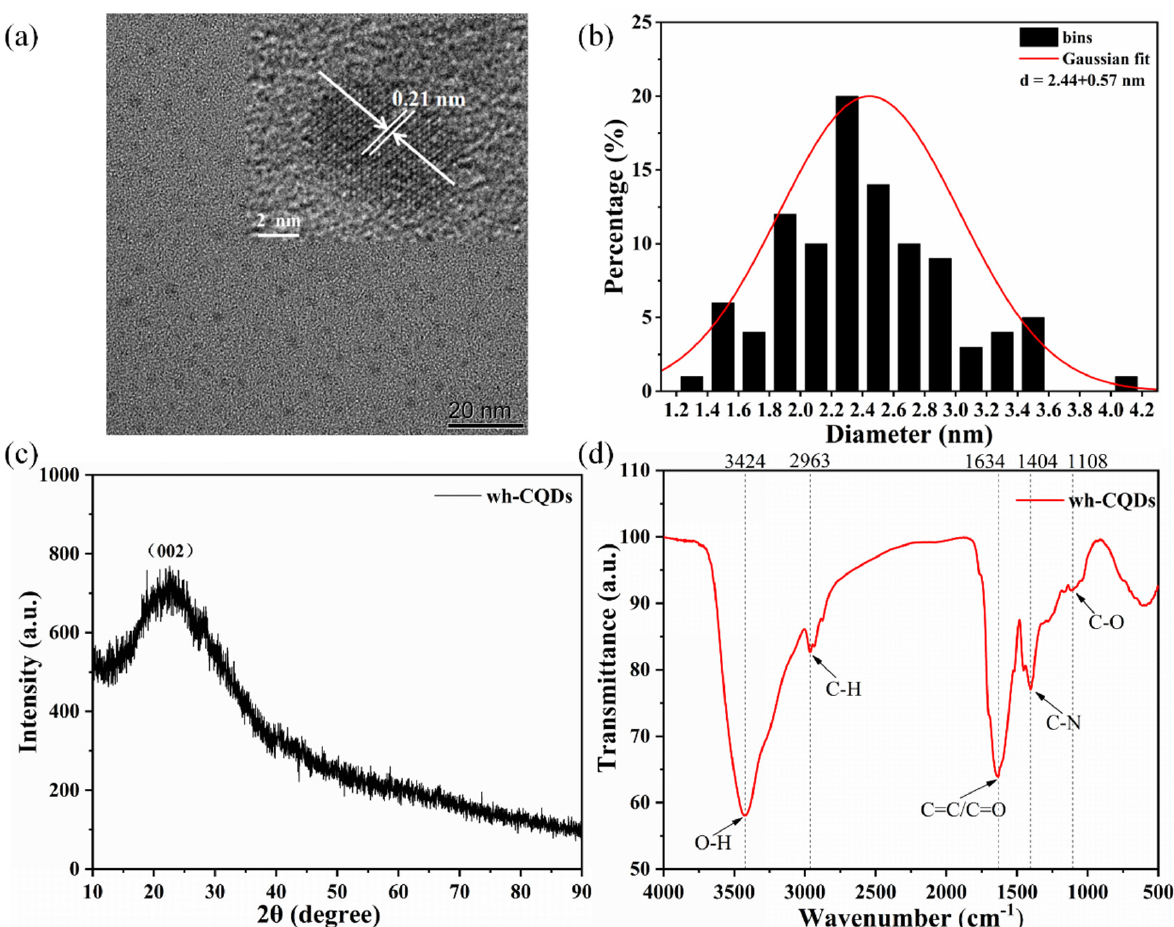
Figure 2. Characterization of wh-CQDs: ( a ) TEM image (inset: HRTEM image), ( b ) the size distribution of particles, ( c ) XRD pattern, ( d ) FTIR spectra.